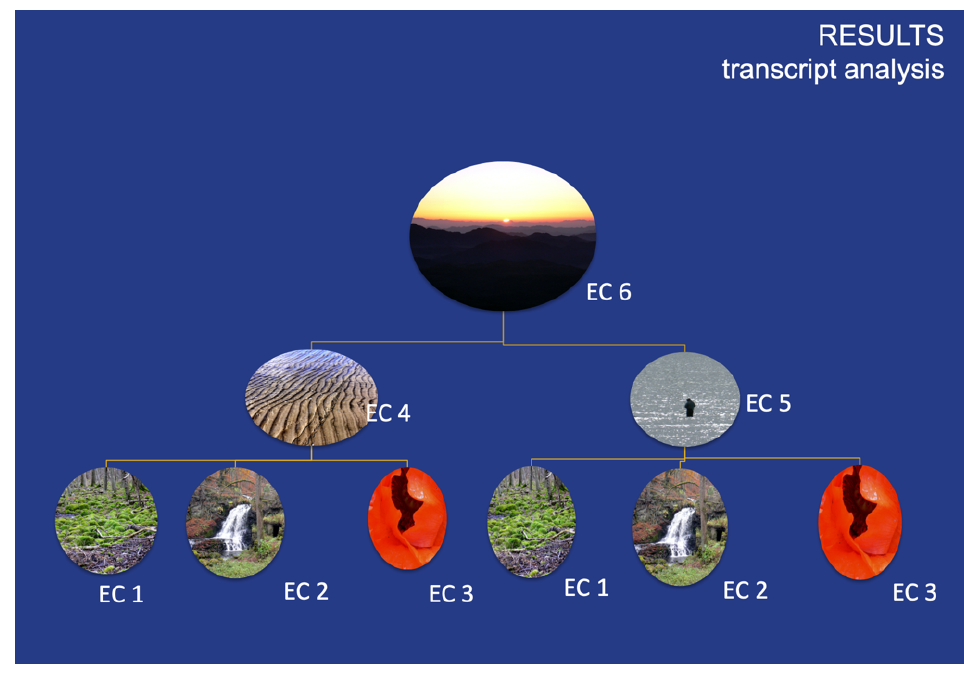
FFigigururee 66 The Quality of Experiential Categories Illustrated in Images. Note:From Mårtenson Blom, Ersta Sköndal University